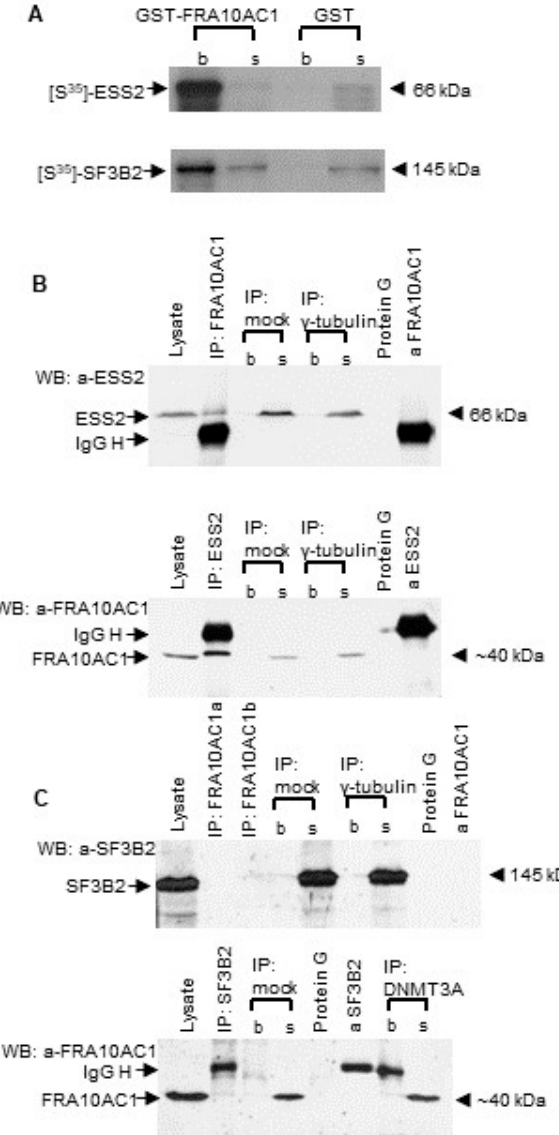
Figure 1. FRA10AC1 protein interaction with two spliceosomal proteins: ( A ) Autoradiogram of a GST pull-down assay of FRA10AC1 with either [S 35 ]-methionine-labeled ESS2 or SF3B2. One tenth (10%) of the preparation was analyzed; b, bound; s, supernatant; GST, negative control. ( B , C ) Endogenous FRA10AC1 co-immunoprecipitates (co-IP) with ESS2 ( B ) but not with SF3B2 ( C ) in HeLa cells. The cell lysate was immunoprecipitated with (i) anti-FRA10AC1- ( B , C , upper panels), (ii) anti-ESS2- ( B , lower panel), and (iii) anti-SF3B2- ( C , lower panel) specific antibodies. For the Western blot (WB), an anti-ESS2 ( B , upper panel), an anti-SF3B2 ( C , upper panel), or an anti-FRA10AC1 ( B , C , lower panels) antibody was used. Negative controls: mock IP (IP without an antibody) and IP with anti- γ -tubulin and anti-DNMT3A antibodies. Runs of a whole protein extract (300 ug lysate), protein G-Sepharose beads, anti-FRA10AC1 ( B , C , upper panels), anti-ESS2 ( B , lower panel) and anti-SF3B2 ( C , lower panel) antibodies were also included in the analysis. IgG H, heavy chain; b, bound; s, supernatant (10% of the unbound fraction); anti-FRA10AC1a and b, 1 ug and 2 ug of the purified antibody.